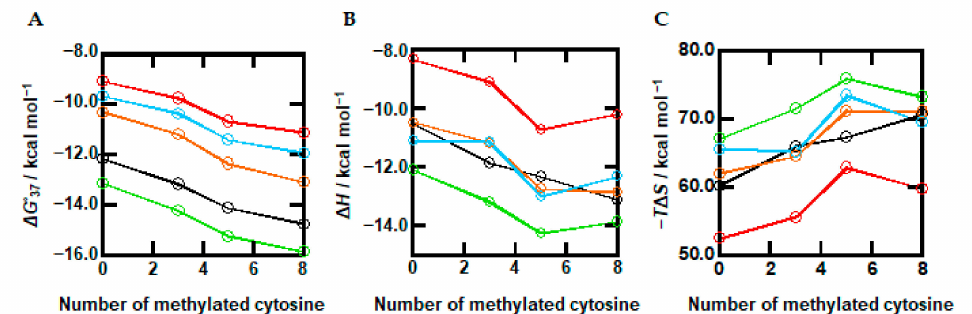
Figure 4. Plots of ∆ G ◦ 37 ( A ), ∆ H ◦ ( B ), and − T ∆ S ◦ ( C ) as a function of methylated cytosine content for oligonucleotides. The parameters were evaluated in 100 mM KCl buffer in the absence of cosolutes (black) or in the presence of 30 wt% PEG200 (orange), TMAO (green), urea (red), or L-proline (blue). Standard deviation ≤ 0.3 ( A ), 3.7 ( B ), and 3.6 ( C